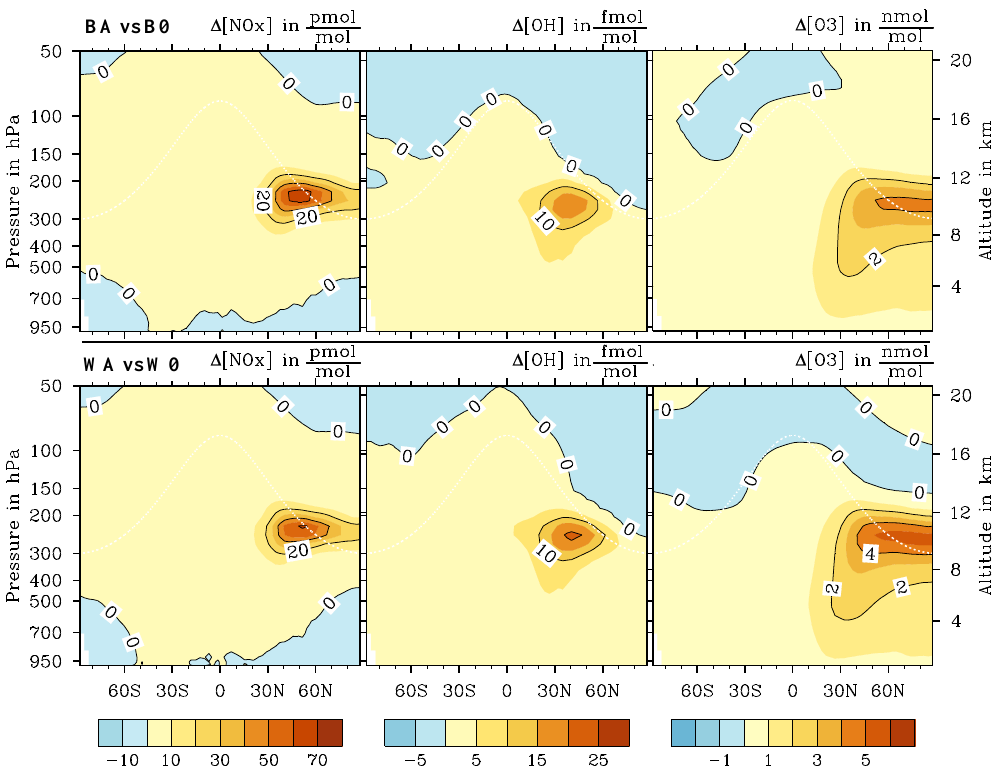
Fig. 2a. Absolute deviations (BA-B0, WA-W0) of annual zonal mean mixing ratios of NO x , OH and O 3 in a simulation with aviation NO x from one without. Simulations without (top), and with HO 2 + NO → HNO 3 assuming a rate coefficient depending on pressure, temperature and humidity